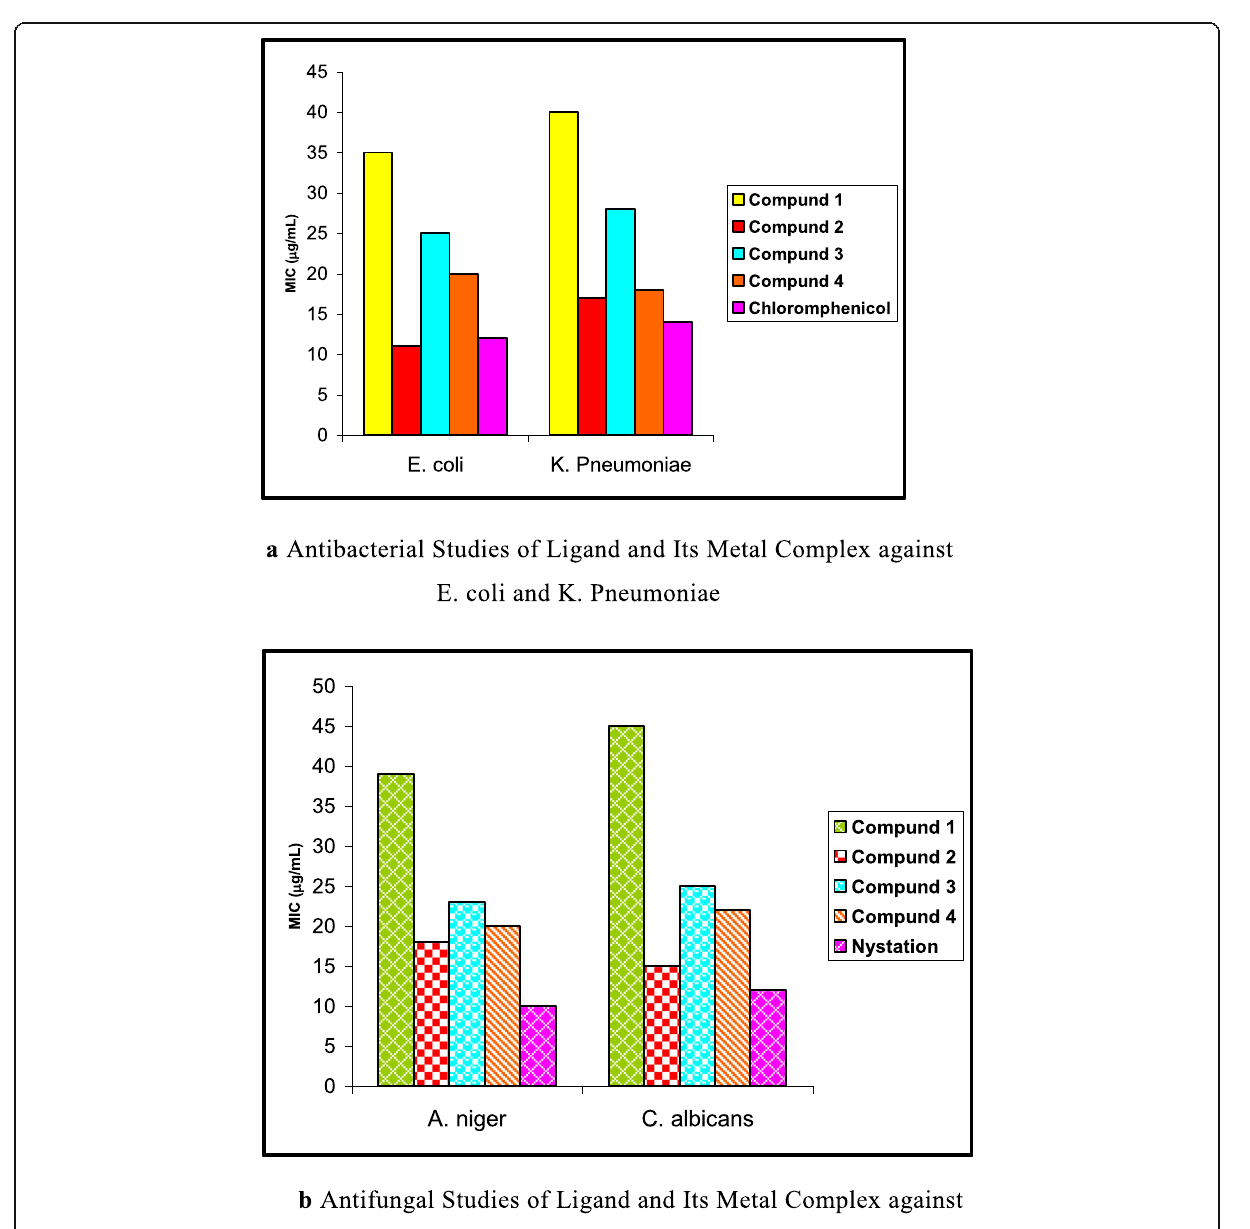
Fig. 2 a Antibacterial studies of ligand and its metal complex against E. coli and K. pneumoniae . b Antifungal studies of ligand and its metal complex against A. niger and C.